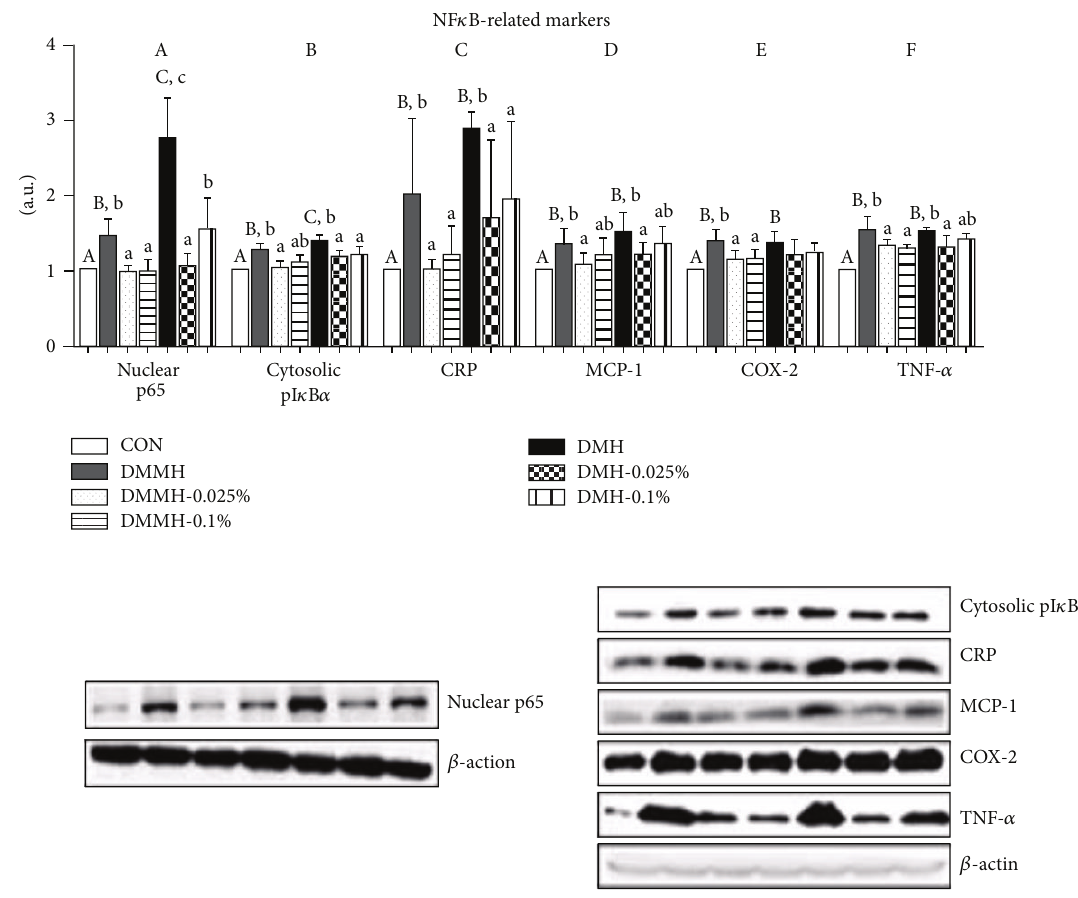
Figure 4: Effect of genistein supplementation on the kidney protein levels of p65 (NF 𝜅 B) (a), pI 𝜅 B 𝛼 (b), CRP (c), MCP-1 (d), COX-2 (e), and TNF- 𝛼 (f) in experimental mice. All results were conducted at least three times. Data are presented as means ± SD ( 𝑛 = 9 -10/group). Mean values with different letters were significantly different, 𝑃 < 0.05 . Statistical differences of variables among CON, DMMH-C, and DMH-C analyzed by one-way ANOVA were shown in capital letters and effects of the genistein supplemented diet and/or DM severity using two-way ANOVA were represented by small